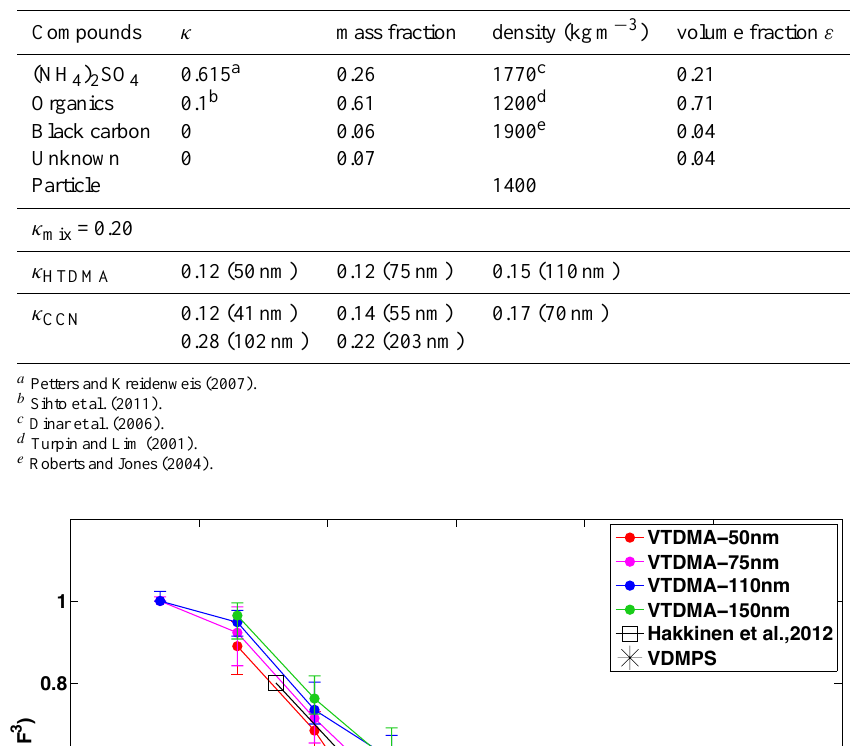
Table 1. Calculated hygroscopicity parameter κ mix based on the Zdanovskii–Stokes–Robinson (ZSR) mixing rule compared with measured κ values using HTDMA ( κ HTDMA ) and CCNC ( κ CCN ). Chemical information used in the calculation was obtained from AMS and aethalometer data. Values ( κ , density) without reference are assumptions. We also assume the unknown species are not hygroscopic and are not taken into calculations for mixtures.